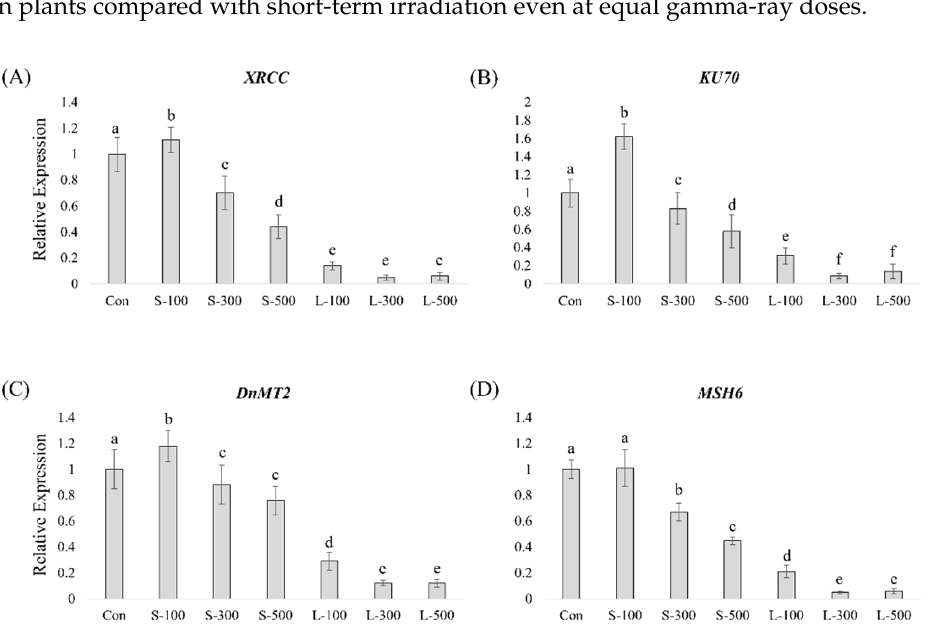
Figure 5. DNA-repair-related gene expression profiling in wheat seedlings determined by RT- qPCR. ( A ) XRCC, ( B ) KU70, ( C ) DnMT2, and ( D ) MSH6. RT-qPCR was performed with three biological replicates, and each bar represents the mean ± SD ( n = 10). Values with different letters are significantly different using Duncan’s multiple range test ( p < 0.05).